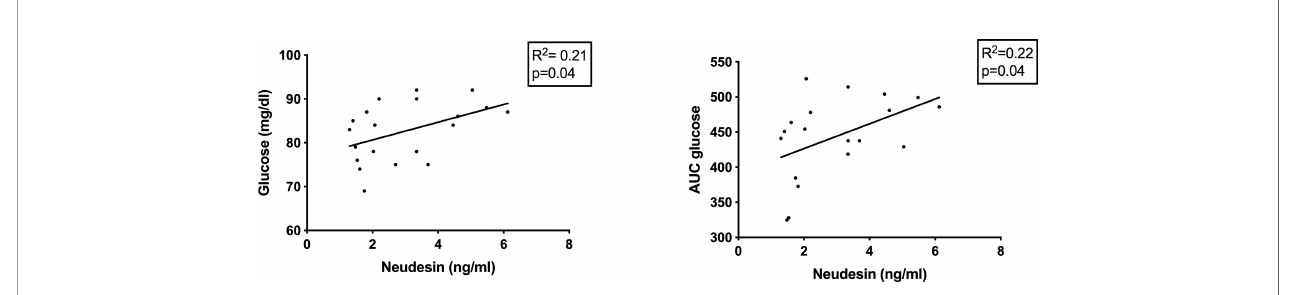
FIGURE 3 | Correlations between plasma neudesin levels, glycemia and glucose AUC after oral load in